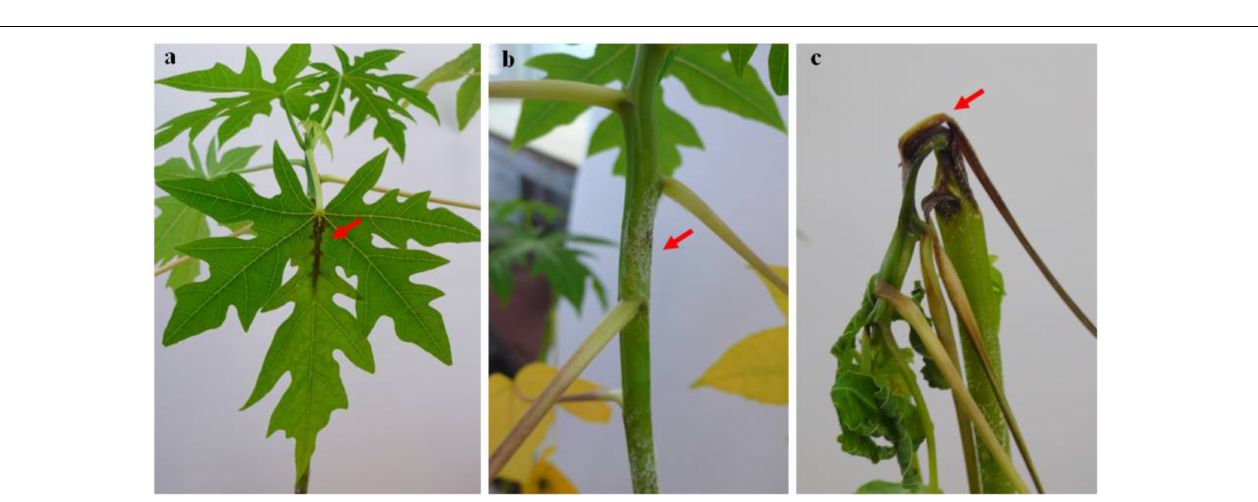
FIGURE 2 | Outbreaks of papaya dieback disease across Malaysia. States affected by the disease from 2003 to 2006. Johor was the first affected state, followed by Perak and other states.